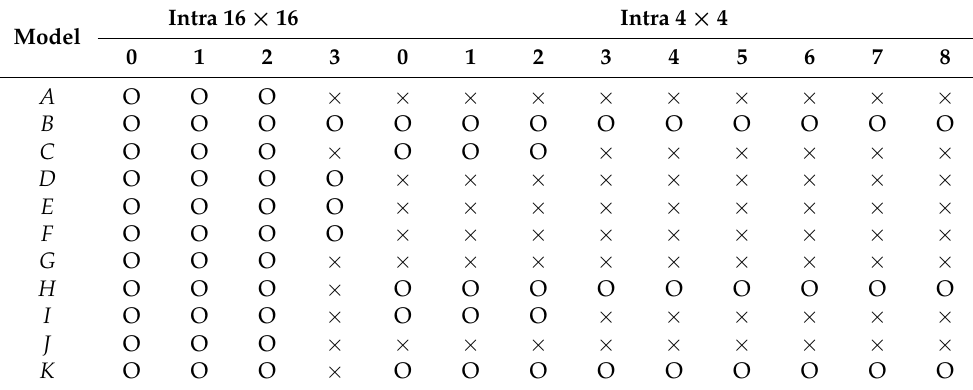
Table 14. Examples of intra prediction modes in H.264 encoder’s descriptors. Here, O and × represent ‘used’ and ‘not used’, respectively.